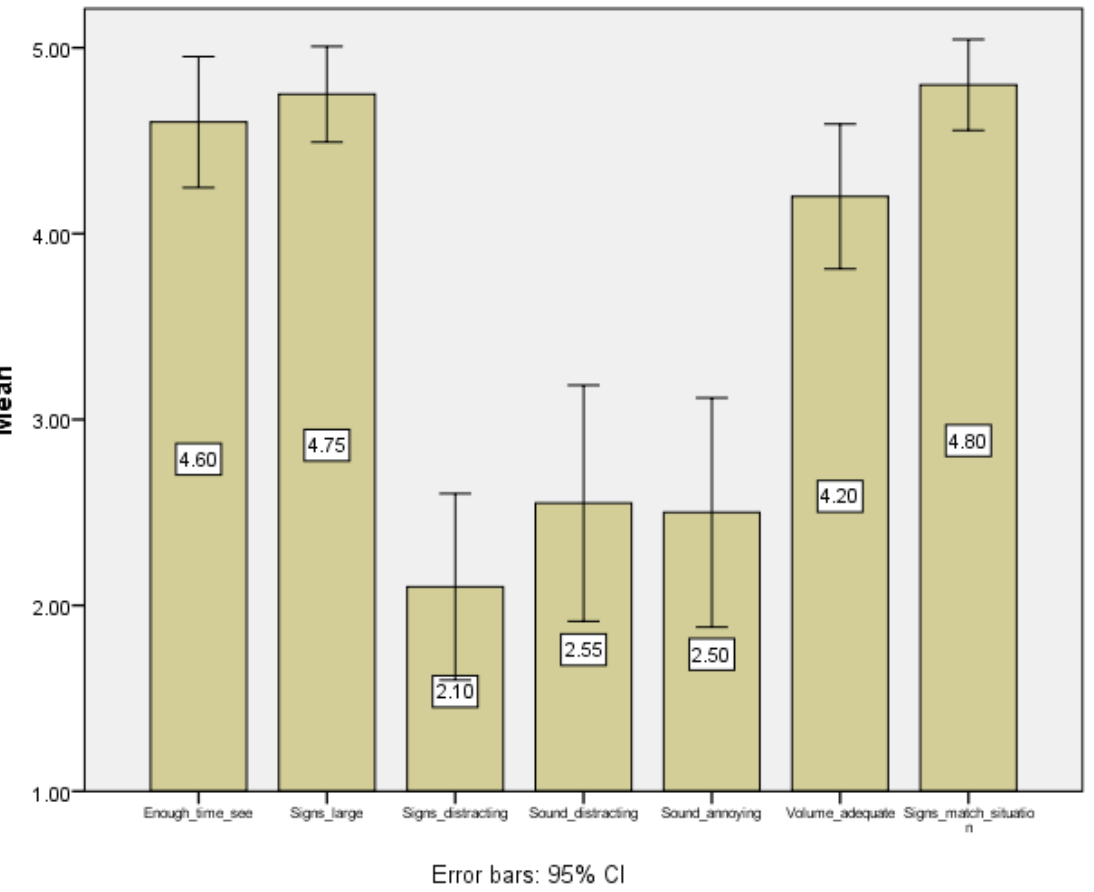
Figure 5. Descriptive statistics of the app usability. The Y axis shows the mean value whereas the different dimensions of usability are shown on the X axis.